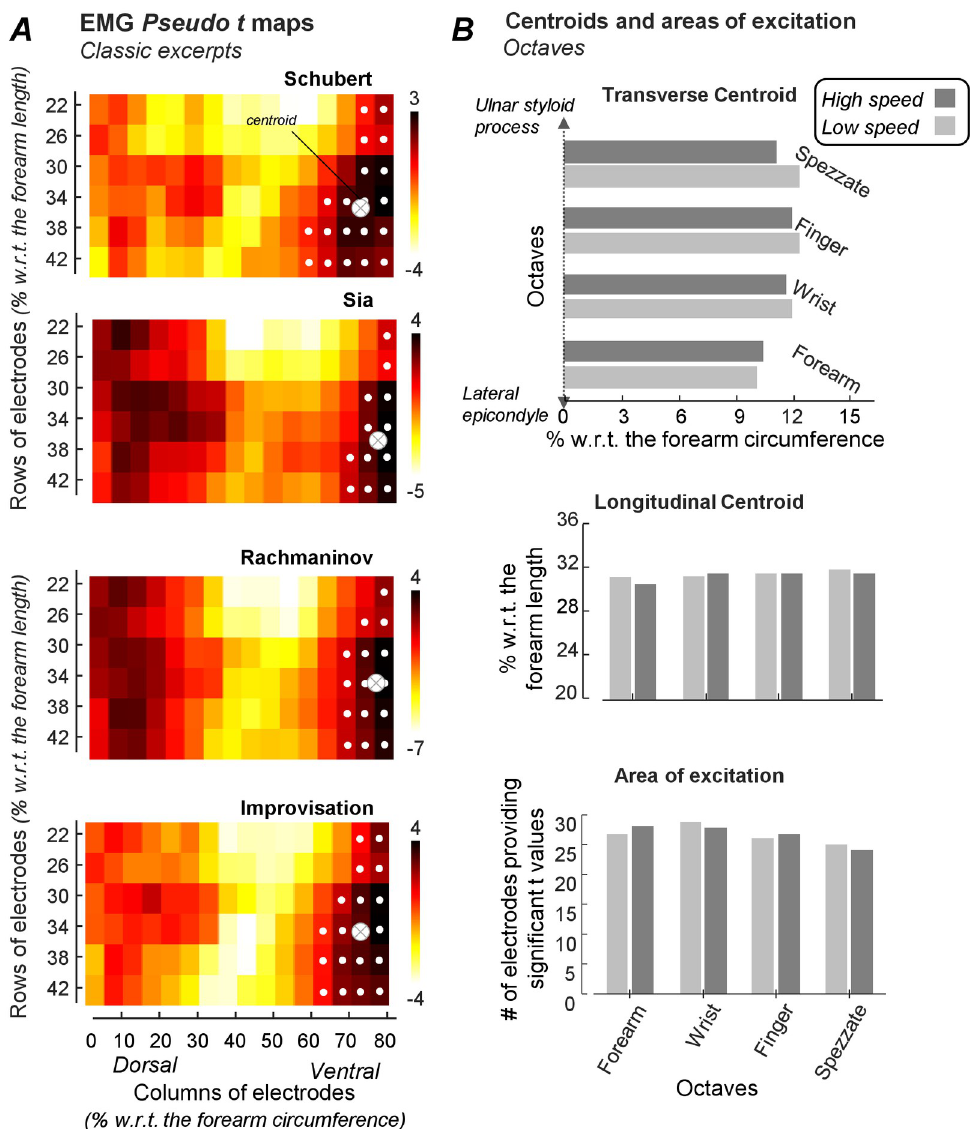
Fig 4. Area and centroids of over-significance-threshold EMGs across subjects. Pseudo t images obtained for classical excerpts are shown in A. White circles denote the region of excitation, defined by pixels providing an average pseudo t value greater than the statistical threshold, set at 5% (Fig 3, Step 4). Crossed circles indicate the centroid of the excitation region, computed as the weighted average of pseudo t values defining the region of excitation. Panel B shows transverse (up) and longitudinal (middle) coordinates of centroids during octaves, as well as the number of electrodes (bottom) defining the region of excitation.